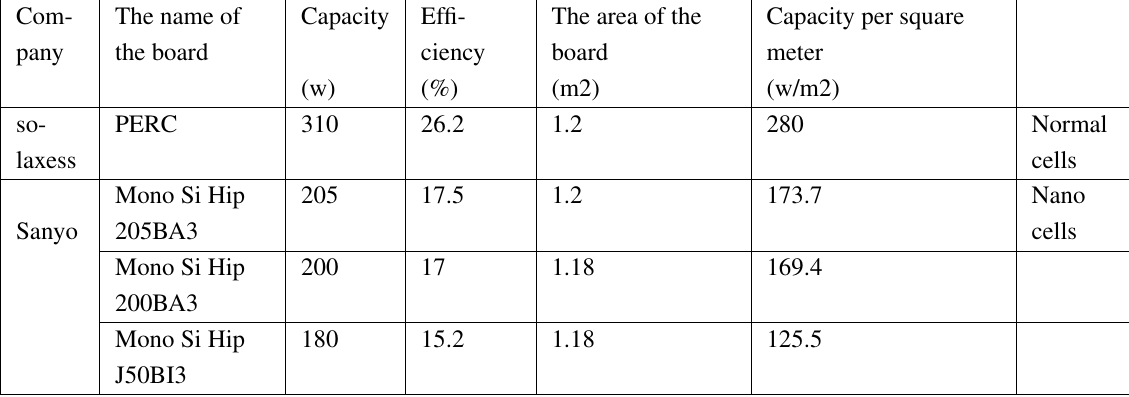
Table 2. Applying the vocabulary of the appropriate photo voltaic system of the study model (Shaded vocabulary is the vocabulary to be weighted) (”Renewable Energy Technologies Screen”,